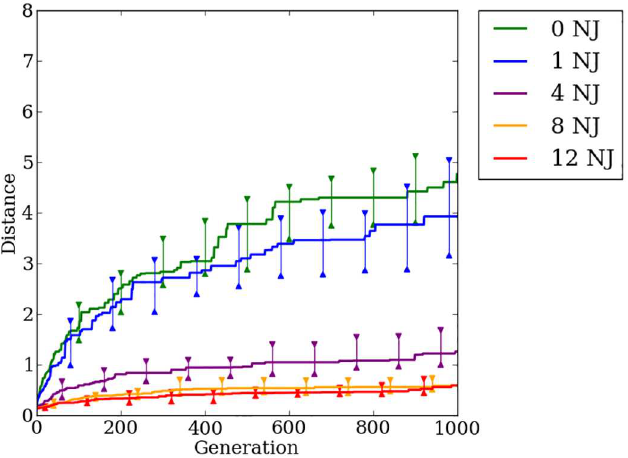
Fig 19. The median distance traveled by Offset-HybrID generation champions over 1,000 generations on the quadruped robot experiment. The line colors indicatethe number of noisy joints on the robot. 95% bootstrapped confidenceintervalsof the medianare shownevery 100